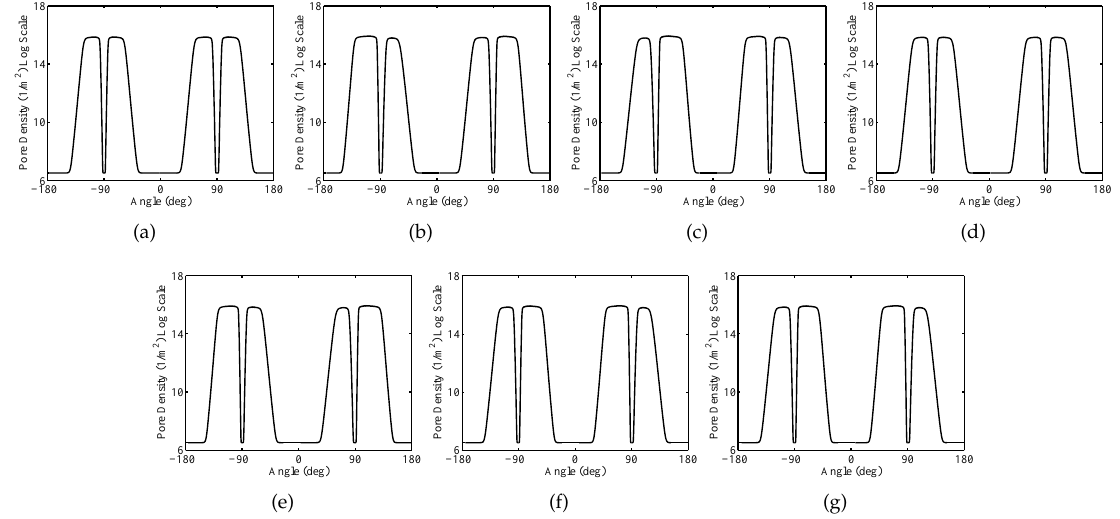
Figure 10. Sparse System—Plasma membranes pore density versus the polar angle at time instant t = 20 ns for ( a ) cell 1, ( b ) cell 2, ( c ) cell 3, ( d ) cell 4, ( e ) cell 5, ( f ) cell 6, ( g ) cell 7.